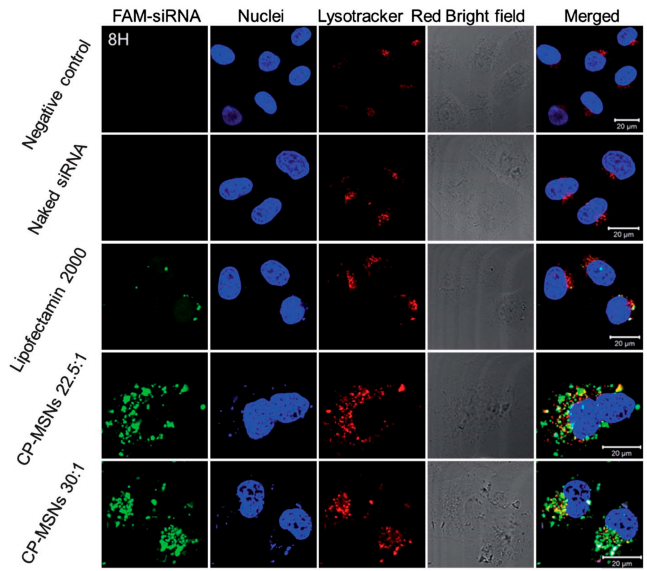
Figure 4. Trafficking of siRNA delivery into HeLa cells with CP-MSNs as carriers and FAM-labeled siRNA as probe (1 µ g/mL). DAPI and Lysotracker was used to stain nucleus and lysosome, respectively. Adapted from reference [62] with